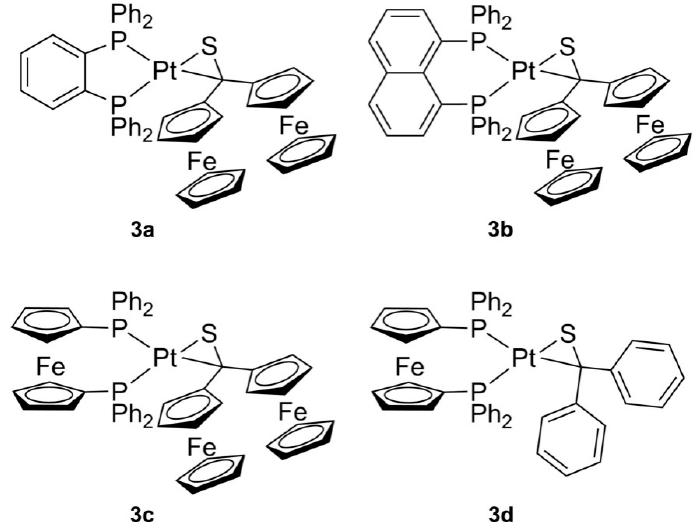
Figure 2. Platinathiiranes 3 a – d investigated in this work.